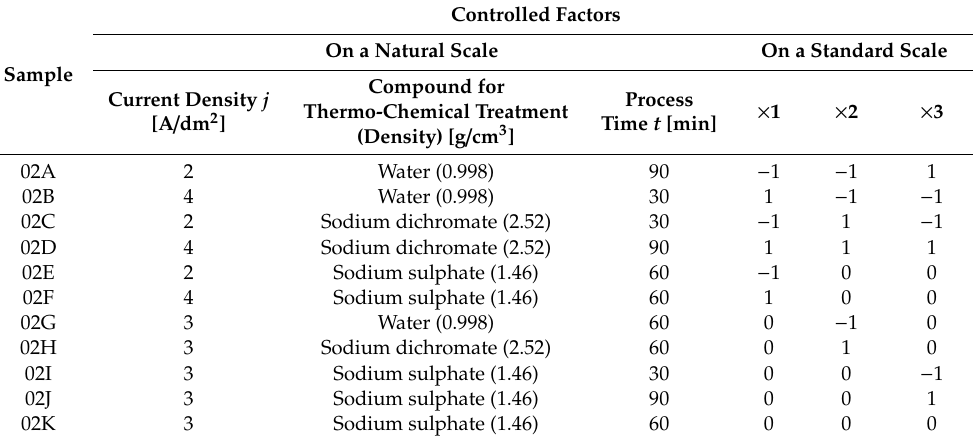
Table 2. List of factors on natural and standard scale for coatings produced in anodizing process and thermo-chemical